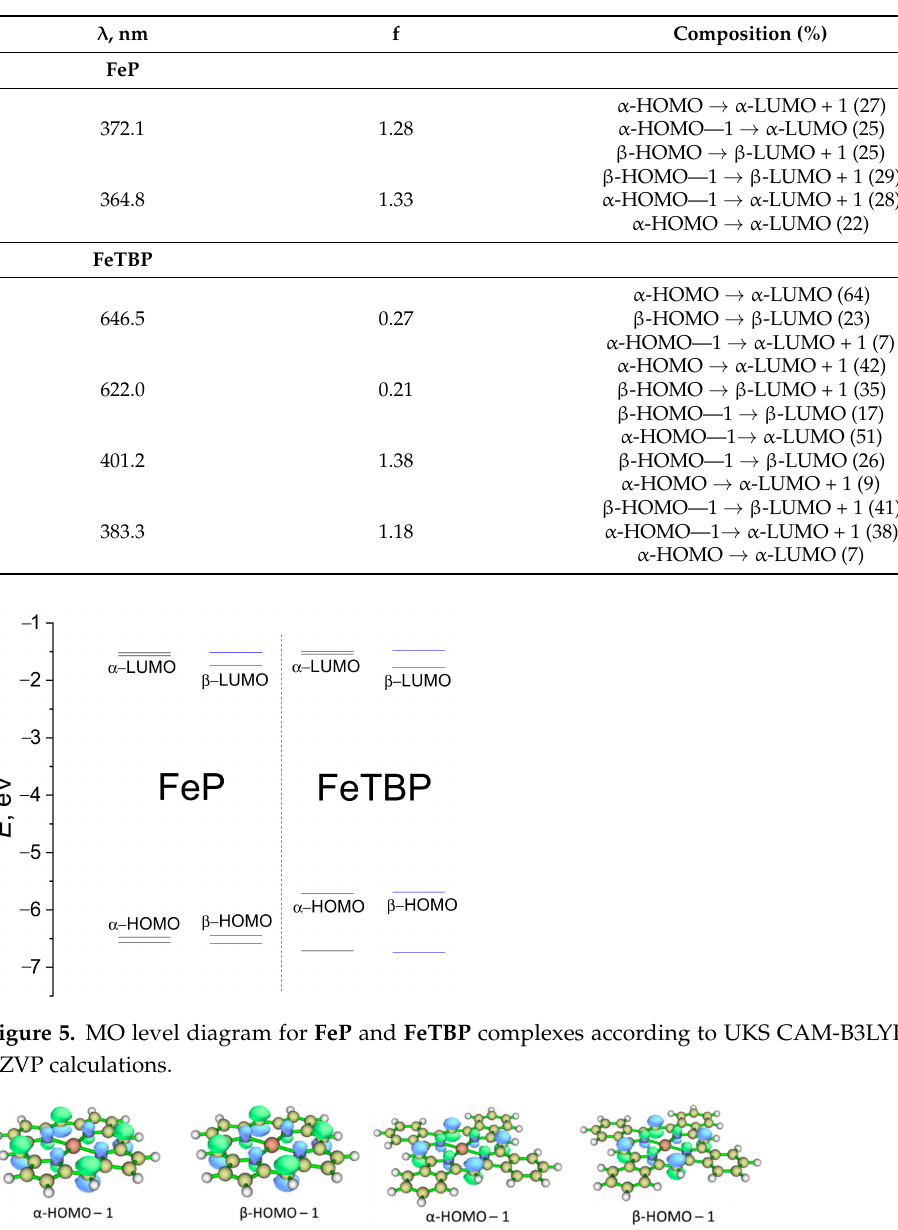
Table 4. Calculated compositions of the selected excited states of FeP and FeTBP , corresponding transition wavelengths, and oscillator strengths.